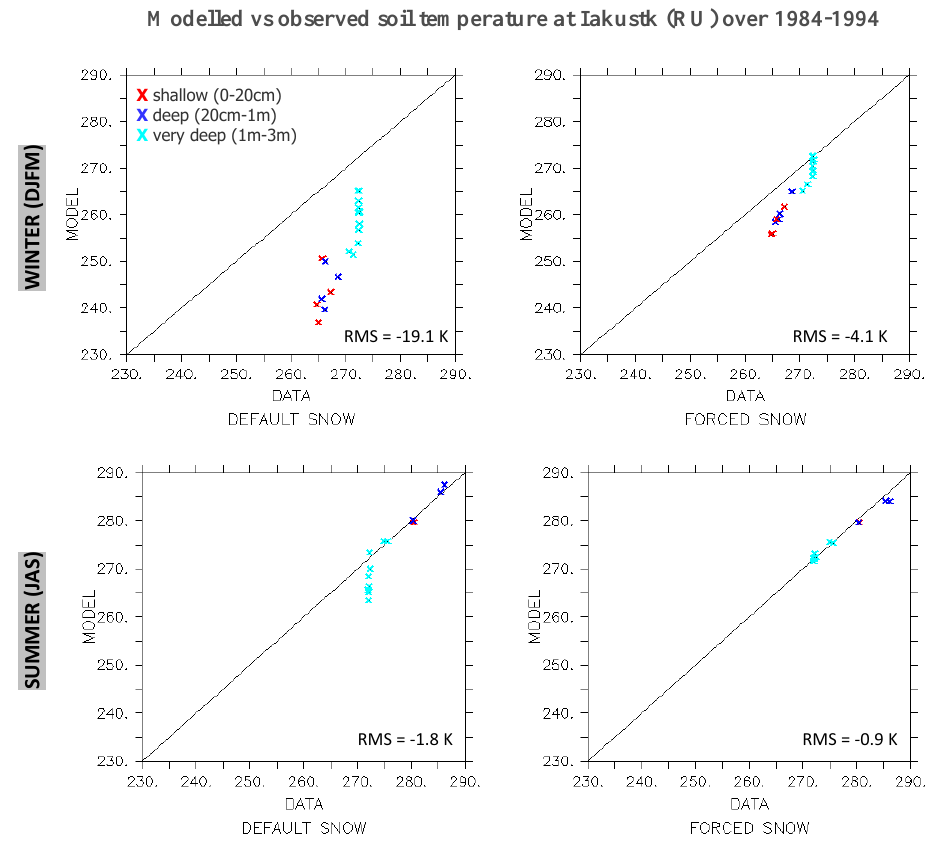
Fig. 9. Comparison between modeled and observed soil temperatures (in K) at different depths (shallow, deep, very deep) at Iakustk in an experiment with the default model snow depth (left) and in a forced-snow experiment (right), where the modeled snow is artificially forced by climatological